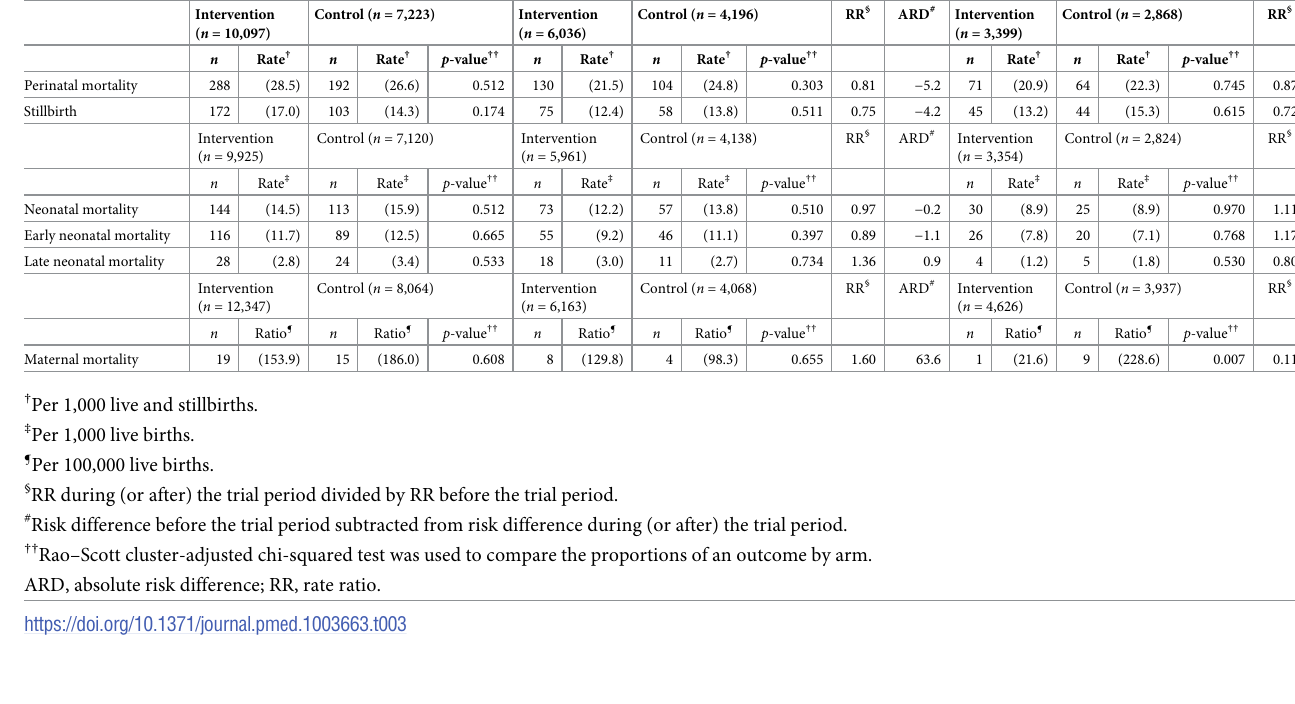
Table 3. Mortality outcomes of this study. Beforethetrialperiod